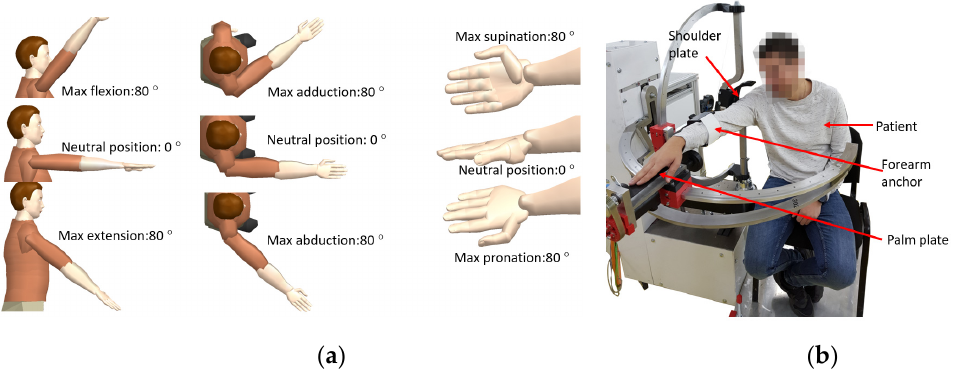
Figure 1. Kinematic scheme of ASPIRE [36].